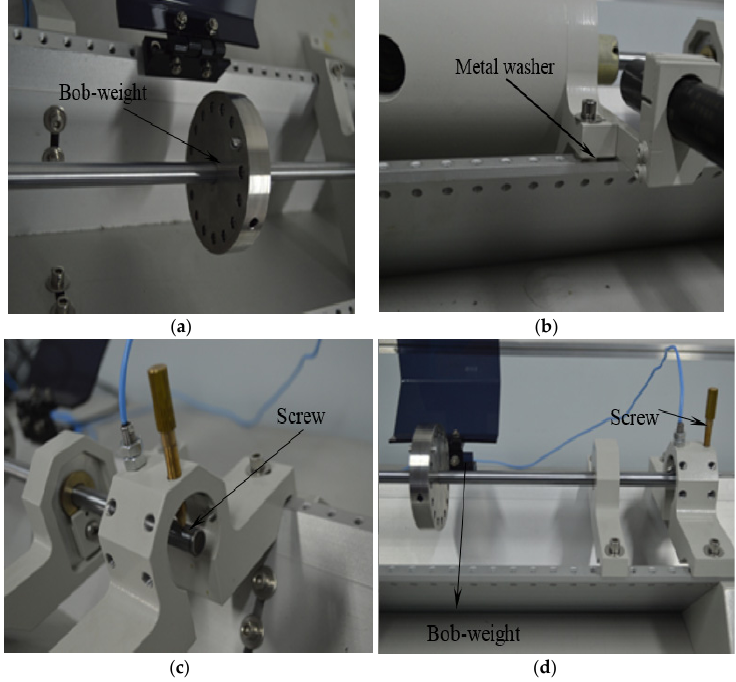
Figure 10. Four faults of a shaft in the experimental operation. ( a ) Unbalance; ( b ) misalignment; ( c ) rub ‐ impact; ( d ) the combination of rub ‐ impact and unbalance.